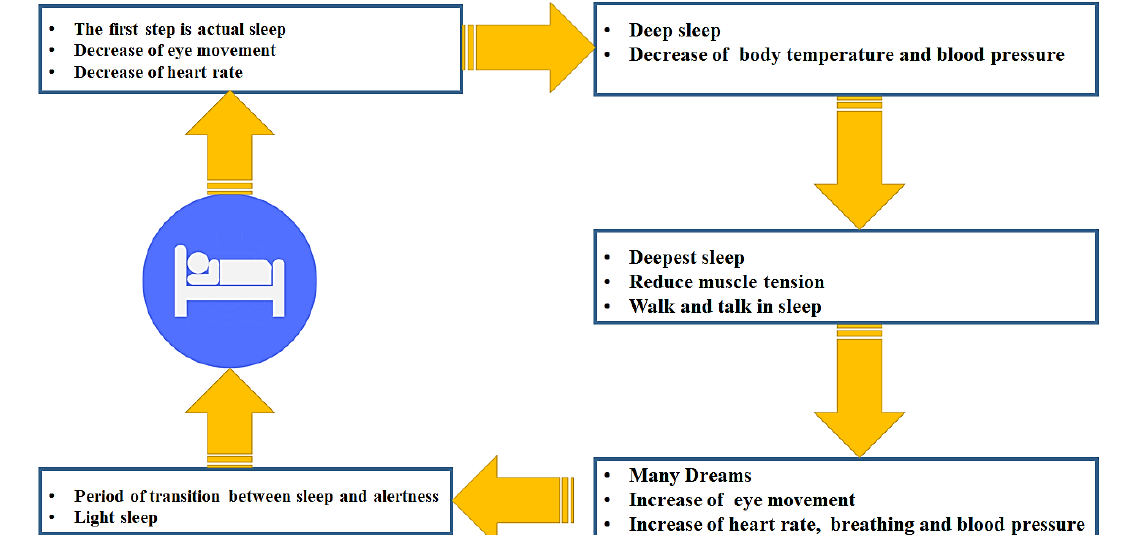
Fig. 1. Different stages of the sleep